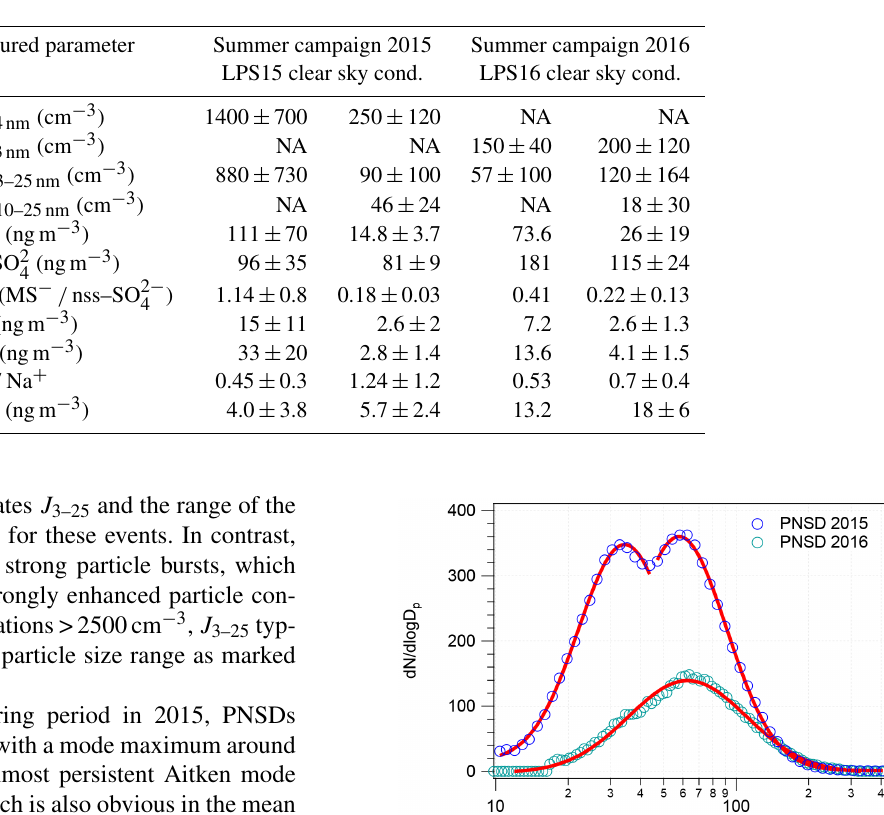
Table 2. Particle number concentrations and ionic composition (mean ± SD) classified into different general weather conditions (impact of low-pressure system and clear sky conditions during both campaigns); note that the ionic composition during LPS16 was based on one sample, and hence no SD can be given. NA – not available.